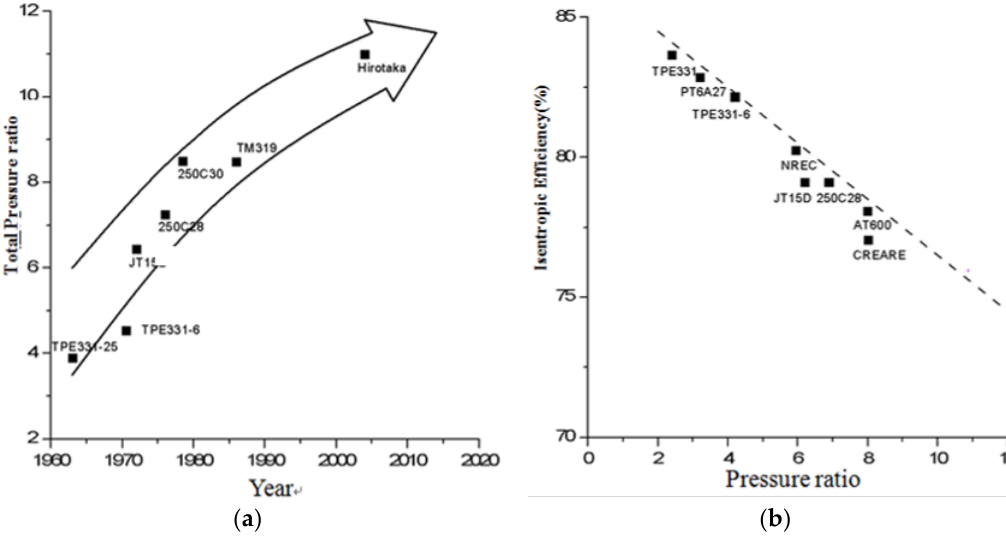
Figure 1. Development trend of centrifugal compressors: ( a ) Development trend of total pressure ratio; ( b ) Relation between pressure ratio and efficiency.